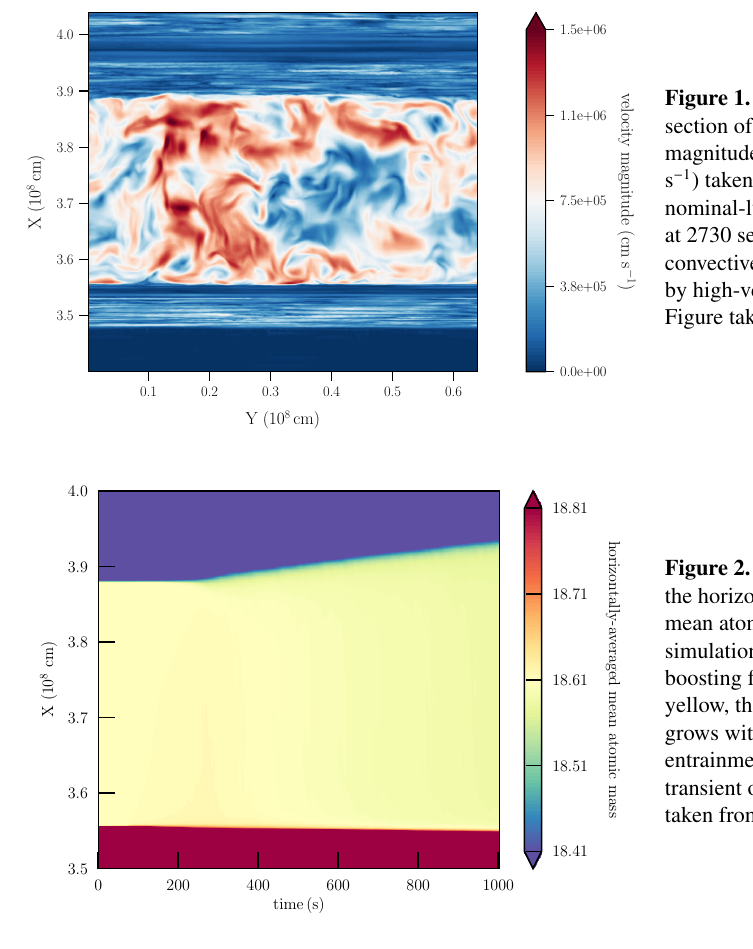
Figure 2. Time evolution of the horizontally-averaged mean atomic mass, for the simulation with energy boosting factor of 10. In yellow, the convective zone grows with time due to entrainment, after an initial transient of ∼ 250 s. Figure taken from